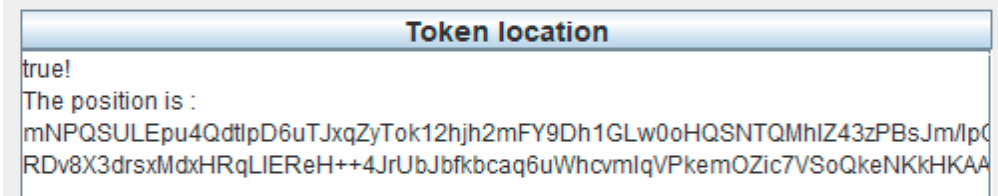
Figure 34. Result of token location.